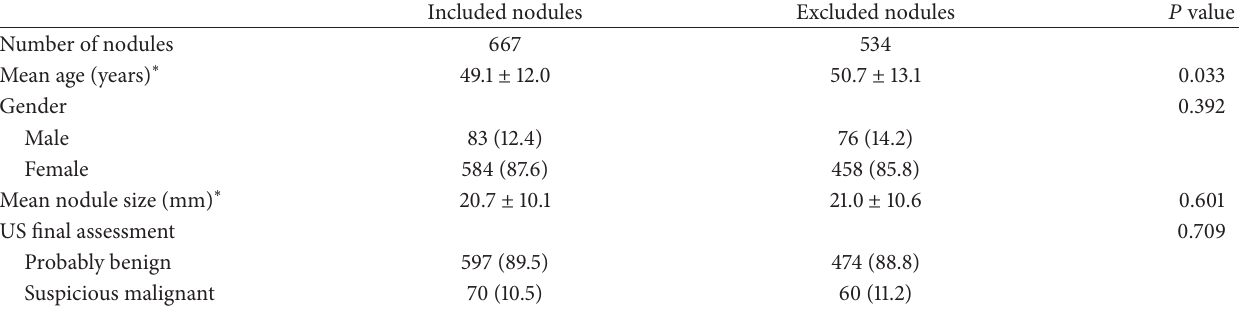
Table 2: Comparison of baseline characteristics of nodules according to inclusion criteria among 1cm or larger 1201 thyroid nodules with benign cytology.